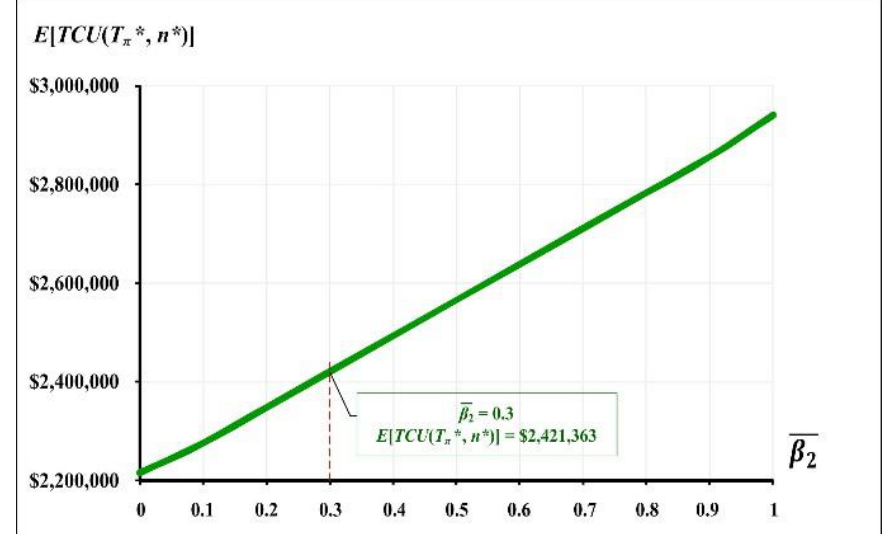
Figure 9. Impact of variations in